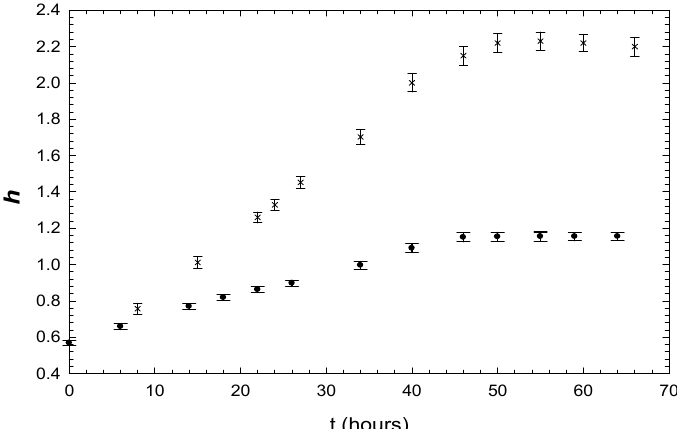
Figure 9. The variation of the height ( h ) with time for grain boundary in the hard (×) and soft cell (•), respectively.